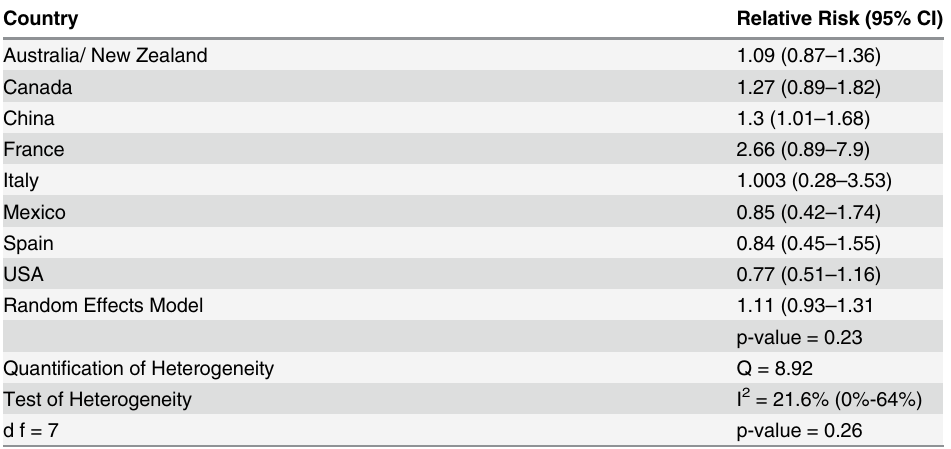
Table 3. Meta-analysis comparing the reported mortality from “ early enrollment ” (the Wave 1 for each individual country) during the H1N1 pandemic with studies describing prolonged enrollment from the same countries. We evaluated the differences in the reported mortality among studies from individual coun- tries by using both a fixed-effects and a random-effects